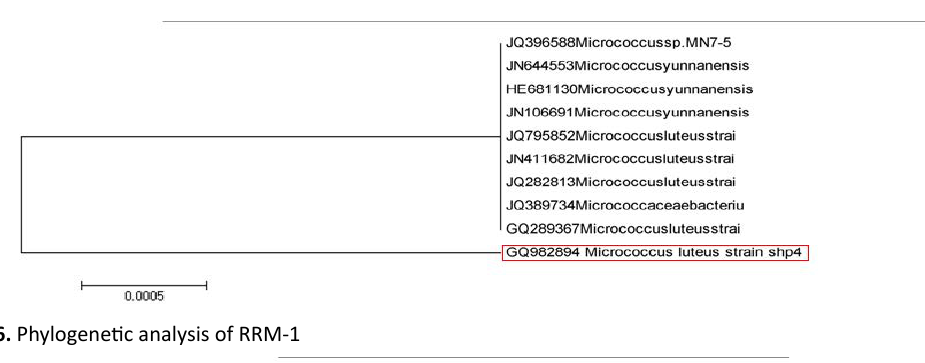
Fig. 6. Phylogenetic analysis of RRM-1